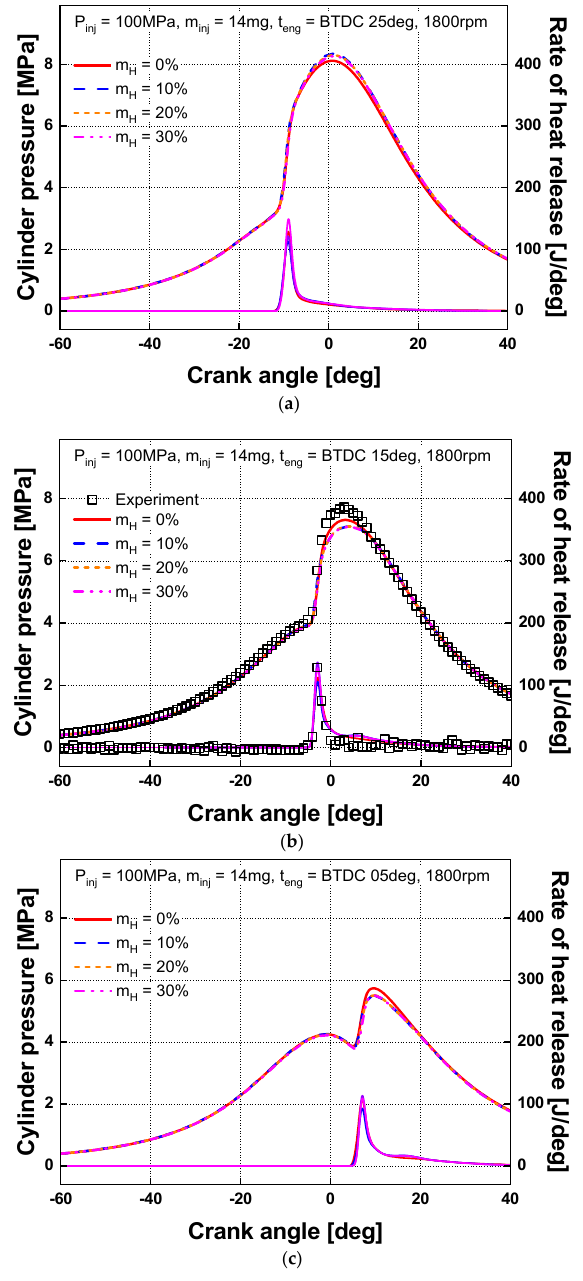
Figure 8. Effect of water vapor portion on the cylinder pressure and ROHR under different starts for energizing timing (P inj = 100 MPa, m inj = 14 mg, 1800 rpm): ( a ) t eng = BTDC 25deg; ( b ) t eng = BTDC 15deg; and ( c ) t eng = BTDC 05deg.